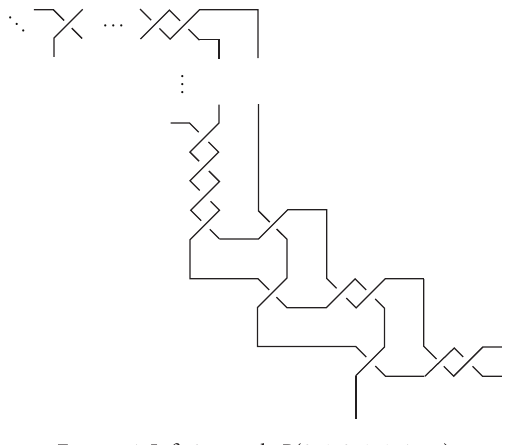
Figure 4: Infinite tangle 𝑅(2,1,2,1,1,4,...) .